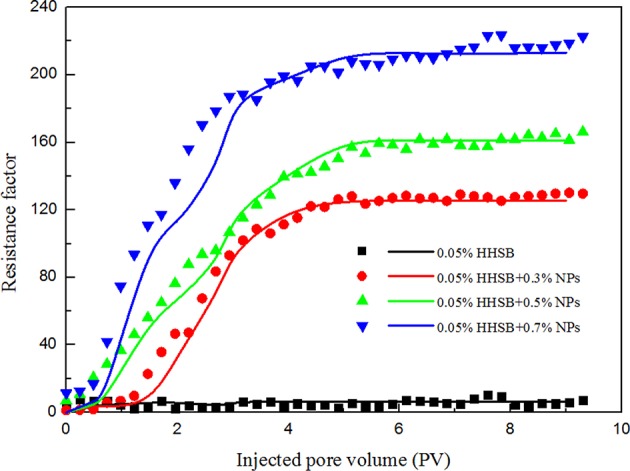
Experimental and simulation results for SC-CO2 foam at 70°C and 8 Mpa (Dots represent experimental results and lines represent simulation results).